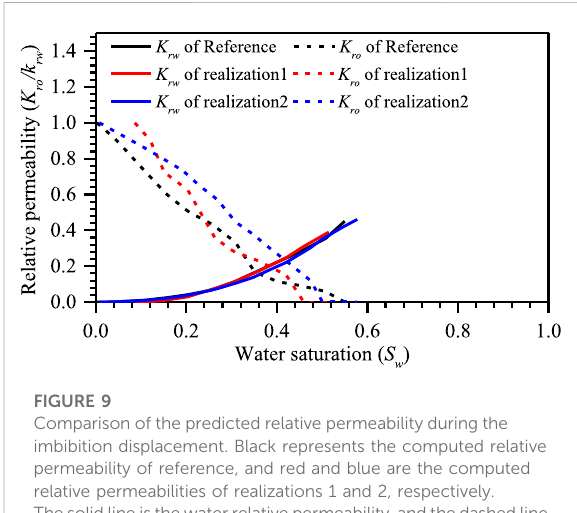
FIGURE 9 Comparison of the predicted relative permeability during the imbibition displacement. Black represents the computed relative permeability of reference, and red and blue are the computed relative permeabilities of realizations 1 and 2, respectively. Thesolidline isthewater relativepermeability,andthedashed line is the oil relative permeability.